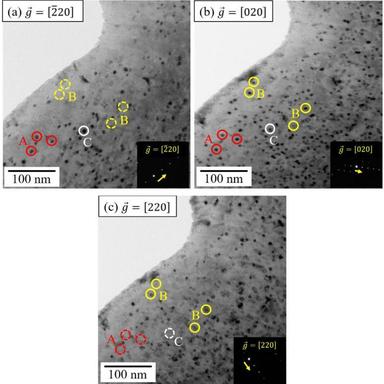
Kinematic bright field images of ThO2 after 0.47 dpa proton irradiation at 600oC obtained using zone and various g conditions: (a) , (b) , and (c) .